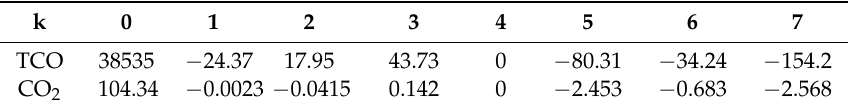
Table 11. The tuned k coefficients of the TCO and CO 2